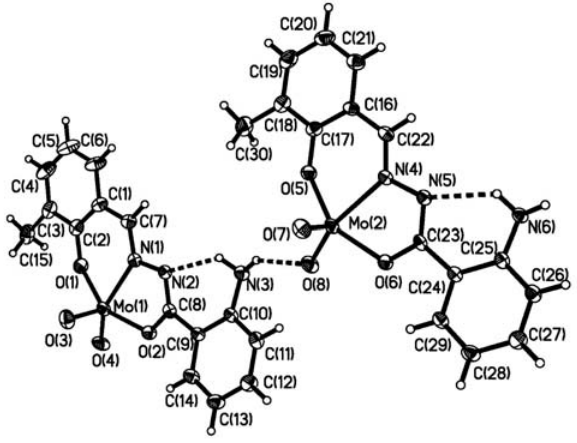
Figure 1. An ORTEP diagram of the complex with atom labeling scheme and 30% probability thermal ellipsoids for all non-hydro- gen atoms. Hydrogen bonds are shown as dashed lines.